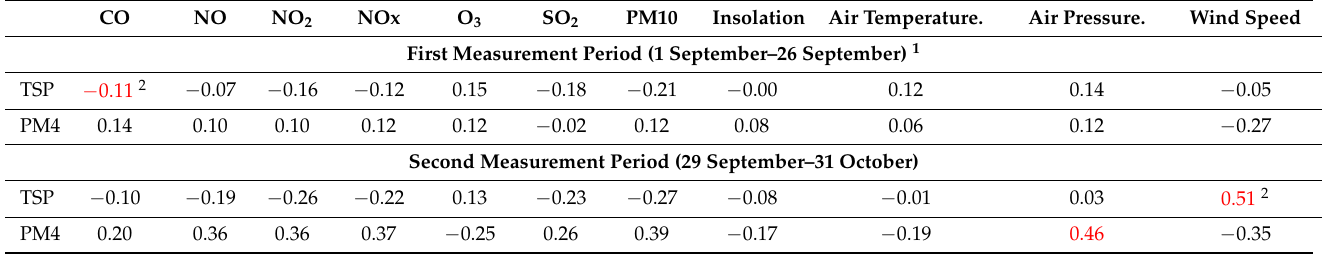
Table 2. Pearson’s linear correlation coefficients ( p = 0.05) of TSP and PM4 concentrations with concentrations of gaseous air pollutants and meteorological